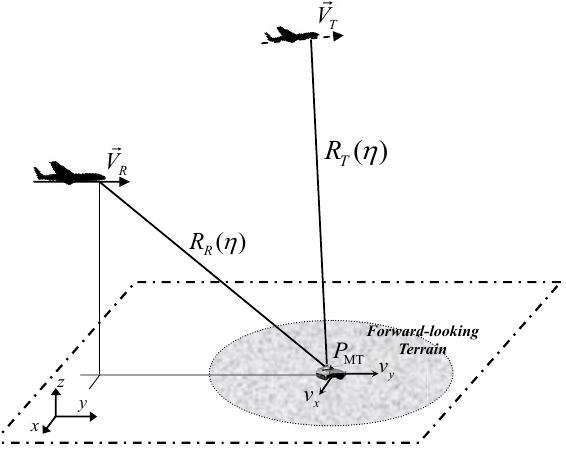
Figure 1. Geometrical relationship between aircrafts and GMT for BFSAR.